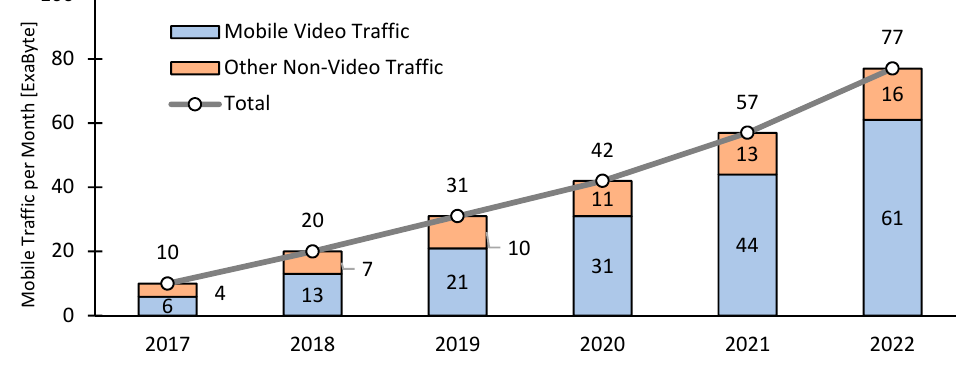
ffi c per month (video and Figure 9. Mobile traffic per month (video and non-video). Figure 9. Mobile tra